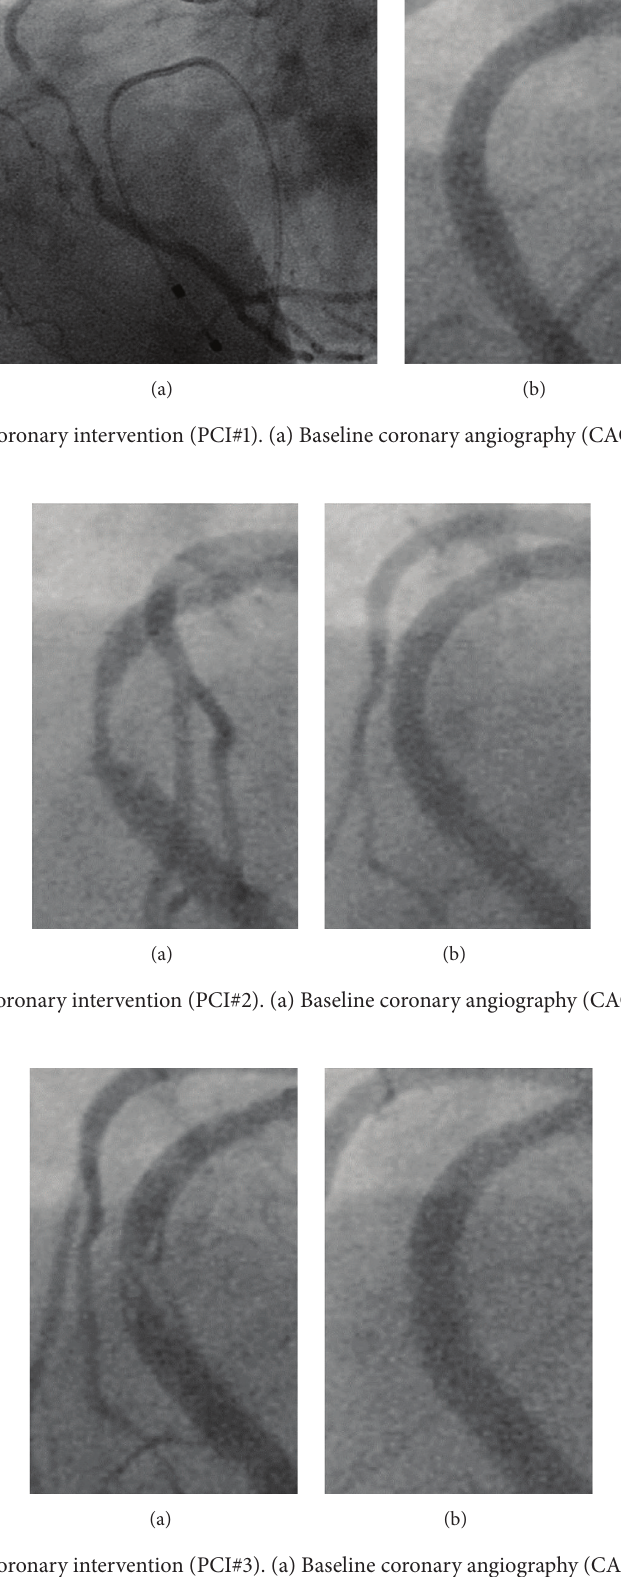
Figure 3: Third percutaneous coronary intervention (PCI#3). (a) Baseline coronary angiography (CAG). (b) CAG after third